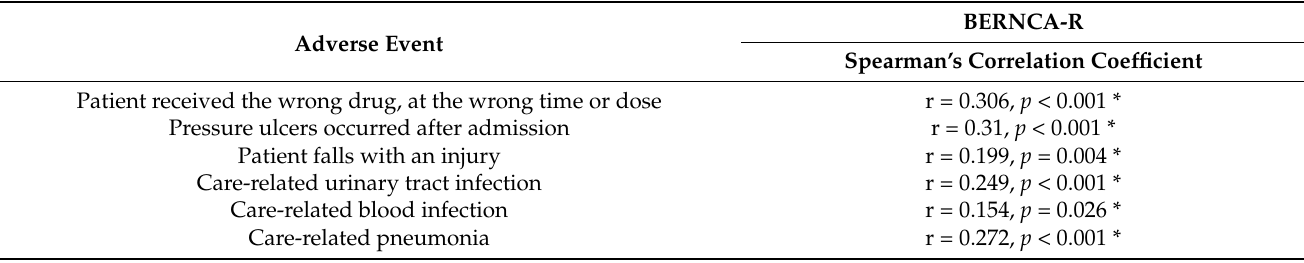
Table 5. Adverse events and care